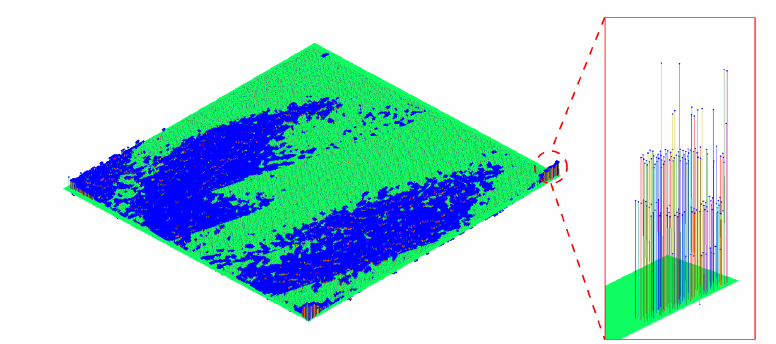
Figure 9. Plane fitting test, visual procedure. (Blue) 3D points of a wall. (Green) plane computed with RANSAC that best fit with the acquired points. The augmented part shows the point to plane orthogonal distances used to carry out this